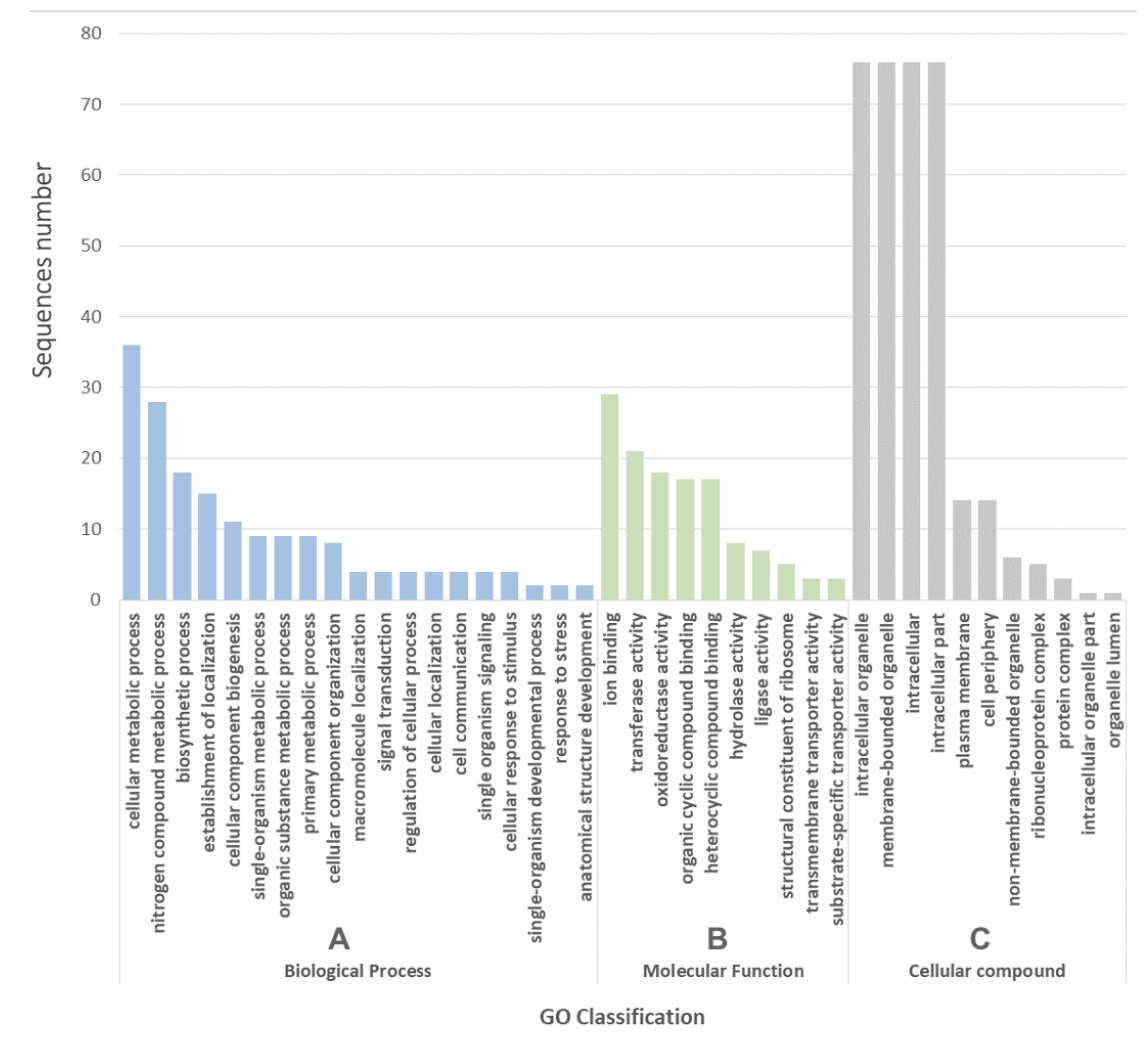
Figure 3. Categorization of ESTs by blast2Go level 2. ( A ) represents biological process; ( B ) represents cellular component; and ( C ) represents molecular function categorization.